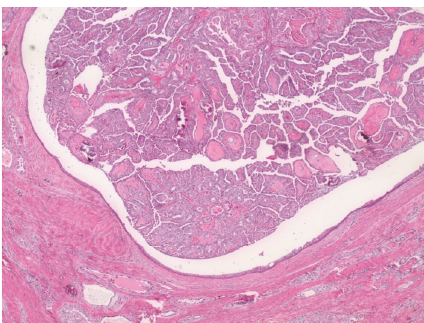
Figure 3: Central neck soft tissue demonstrating a cystic structure, withinwhichisaproliferationoffibrovascularcores(H&Estain,40x original magnification).